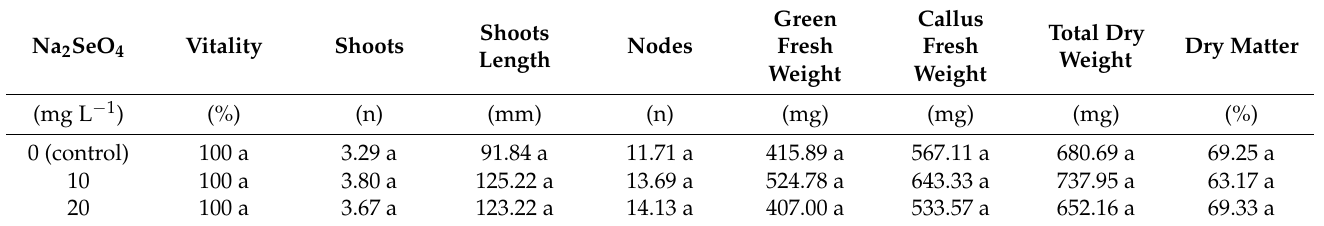
In each column, mean values ± SE followed by different letters were significantly different ( p <